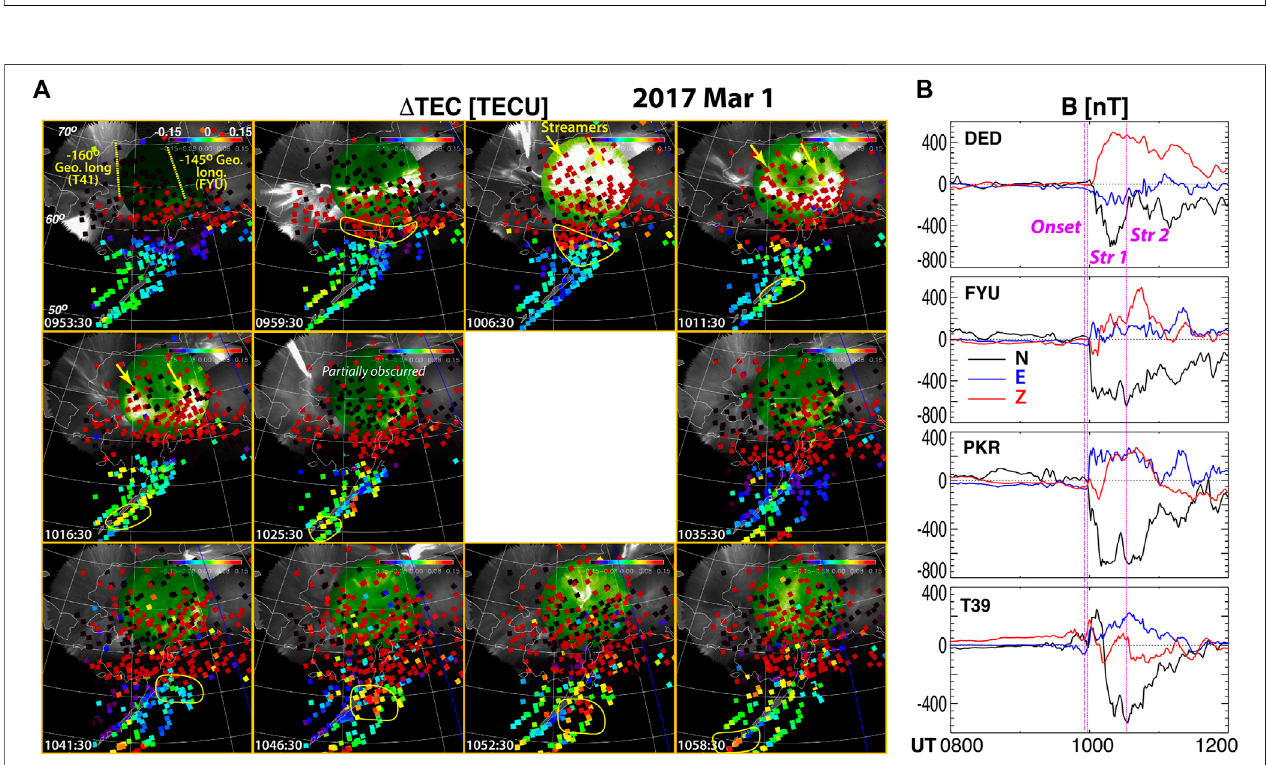
FIGURE5|(A) SequenceoftheauroralimagesduringtheperiodofinterestonMarch1,2017(557.7 nmemissionsfromthePokerFlatASIwithTHEMISASIwhite light emissions in regions outside the Poker Flat ASI fi eld-of-view, FOV), overlaid with all available Δ TEC measurements over the Alaska sector. Yellow curves encircle equatorward moving regions of Δ TEC enhancements equatorward of the auroral oval. The blank square separates the time periods of the two TIDs. Dark blue line is the magnetic midnight meridian, and longitude lines are spaced 15 ° apart. (B) Ground magnetometer observations from stations approximately along the Poker Flat meridian stacked from lower to higher